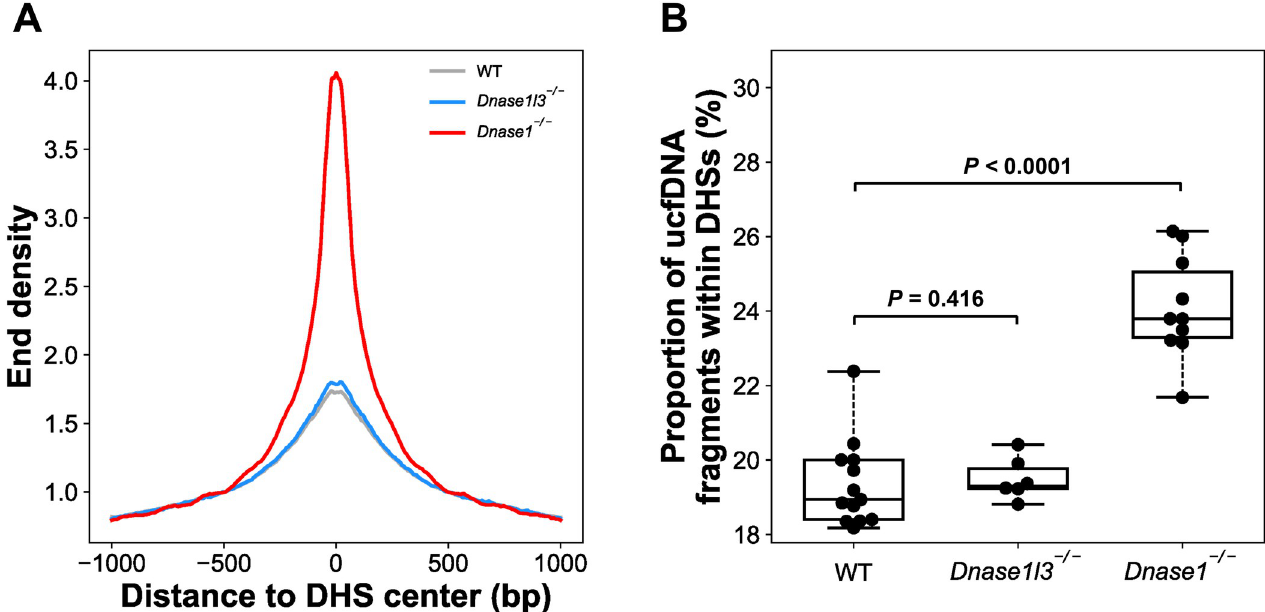
Fig 7. End density of the ucfDNA fragments within the DHSs. (A) End density of ucfDNA fragments across the regions close to the DHSs. The grey, blue and red lines represent the median end density derived from WT (n = 13), Dnase1l3 -/- (n = 6), and Dnase1 -/- groups (n = 10), respectively. (B) Proportion of ucfDNA fragments falling within the